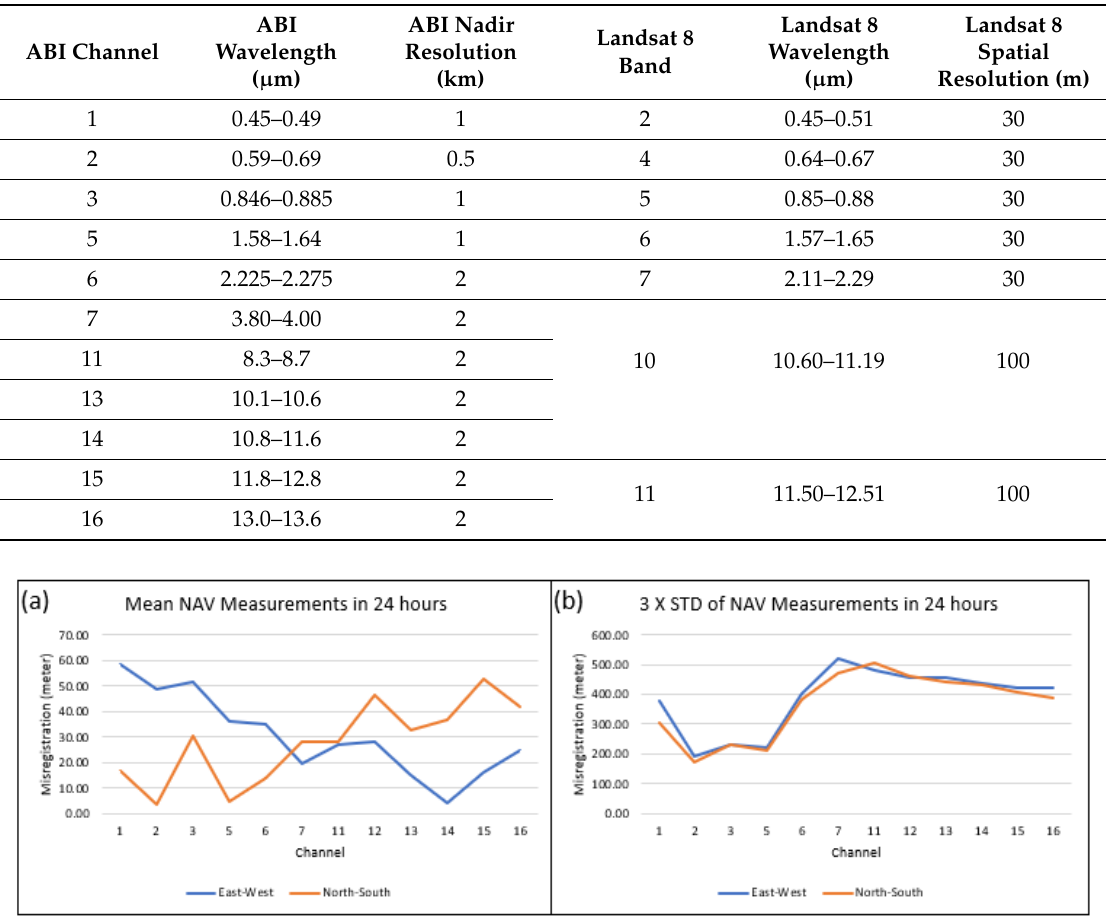
Figure 14. The mean ( a ) and 3 times standard deviation ( b ) of navigation error of a 24-hour period (June 1st 18:00 UTC to June 2nd 17:59 UTC 2019) for GOES-16. The misregistration is converted to nadir equivalent distance from the angular space of the fixed grid projection.